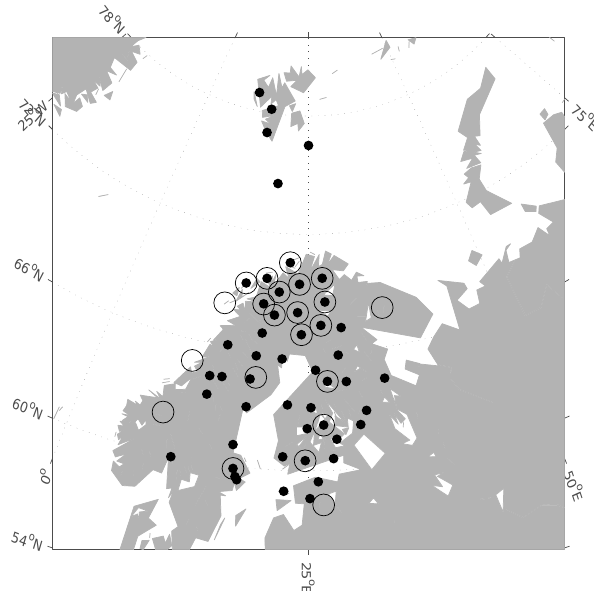
Fig. 1. Location of magnetometer sites used for the derivation of the original source currents (black dots) and the location of sites used for the derivation of the currents used in the comparison (circles). Geographic coordinates are used.